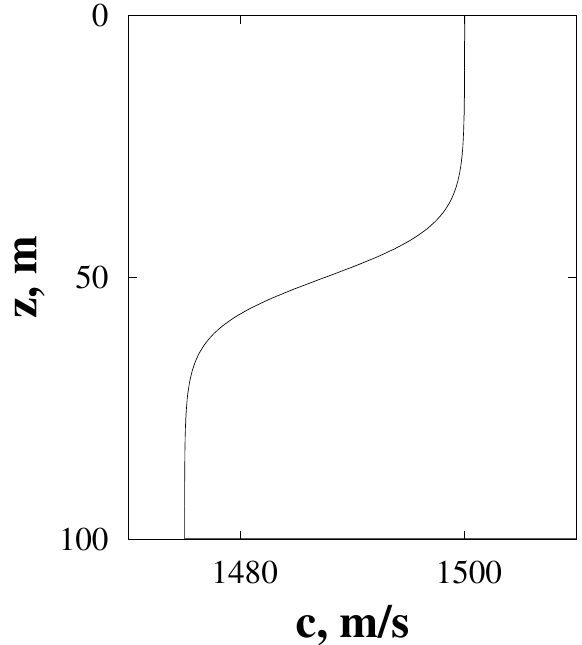
Figure 1. Sound-speed profile in the water layer